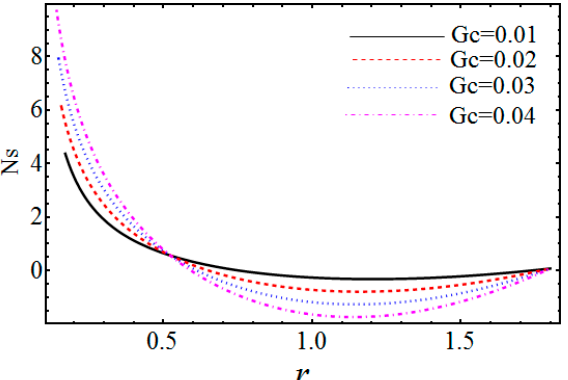
Figure 13. Curves of Ns with fixed Gc where θ = 0.1, ϕ = 0.5, δ = 0.01, ε = 0.01, V = 0.3, λ 1 = Figure 13. Curves of 𝑁𝑠 with fixed 𝐺𝑐 where 𝜃 = 0.1, 𝜑 = 0.5, 𝛿 = 0.01,𝜀 = 0.01,𝑉 = 0.3, 𝜆 (cid:2869) = 1, z = 0, t = 0.1, Γ = 0.4, Nb = 0.9, Nt = 0.5, Br = 1, Gr = 3, Λ = 0.4, Ω = 0.3, Q = 1. 1, 𝑧 = 0,𝑡 = 0.1,Γ = 0.4, 𝑁𝑏 = 0.9, 𝑁𝑡 = 0.5,𝐵𝑟 = 1, 𝐺𝑟 = 3, Λ = 0.4, Ω = 0.3, 𝑄 = 1.